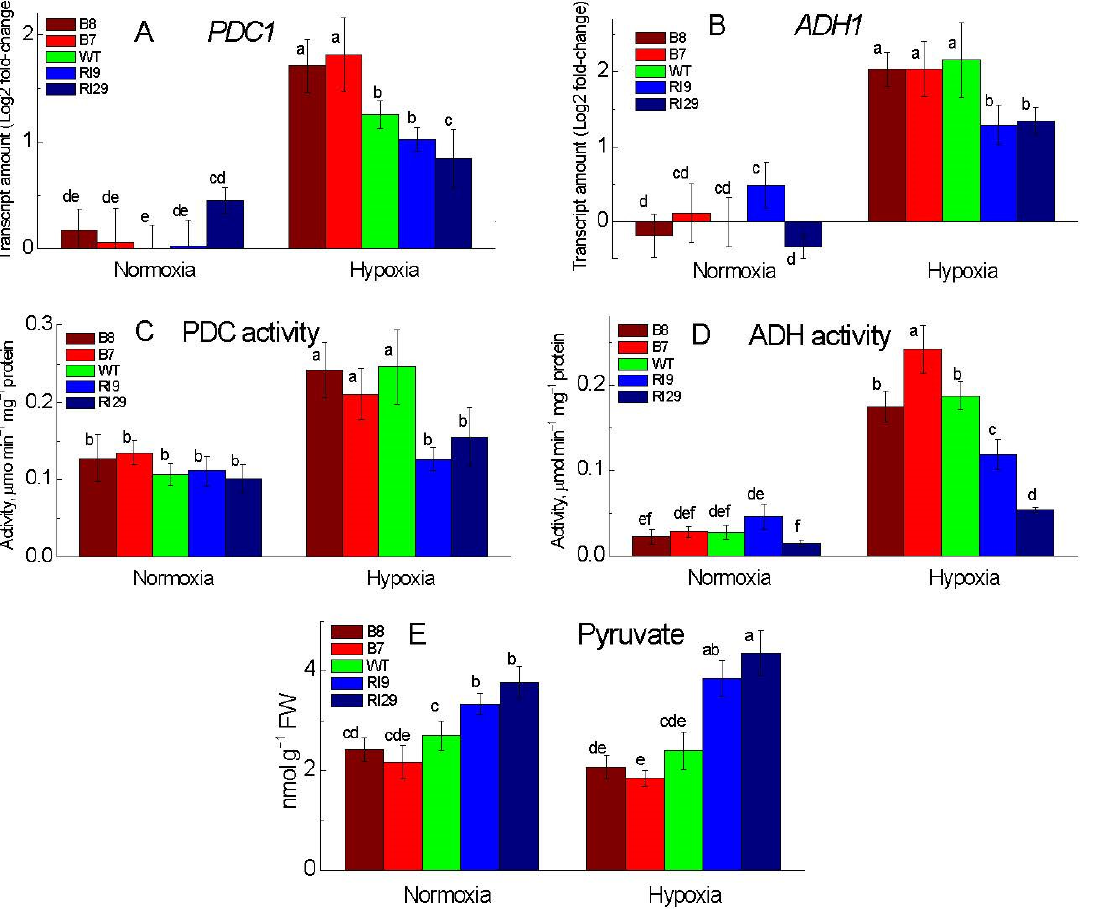
Figure 5. Transcript levels ( A , B ) and activities ( C , D ) of fermentation enzymes and pyruvate levels ( E ) in leaves of tobacco plants exposed to normoxia and 6 h hypoxia. ( A , C ) Pyruvate decarboxylase (PDC) and ( B , D ) alcohol dehydrogenase (ADH). The plant lines used included the wild type (WT), two alternative oxidase overexpressors (B7 and B8), and two alternative oxidase knockdowns (RI9 and RI29). Vertical bars indicate SD from three to four independent experiments ( n = 3–4); different letters indicate significant differences between five tobacco lines and the